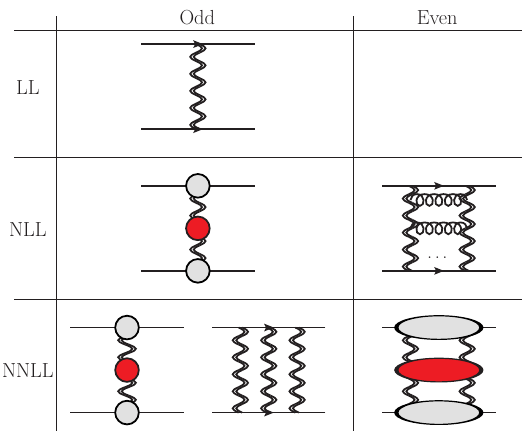
Figure 1: Schematic relation between logarithmic counting and Reggeon exchanges for two-parton amplitudes in the high-energy limit. The grey blobs represent impact factors, while the red ones are corrections to the Regge